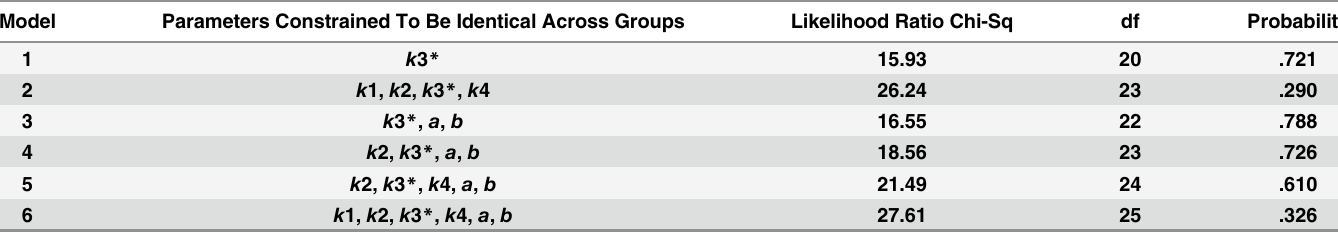
Table 4. Results of Fitting Models to Italian Data. Model Parameters Constrained To Be Identical Across